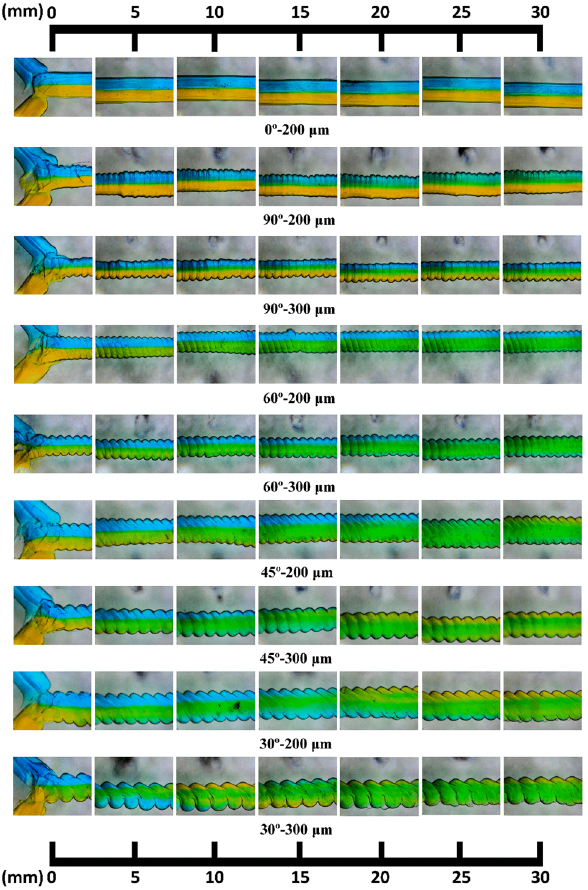
Figure 5. Optical images of the colorimetric experiments with a flow rate of 120 μL/min at each inlet. The water dyed in blue and yellow colors was injected at the two inlets. The green color indicated the fluid mixed with blue and yellow-colored